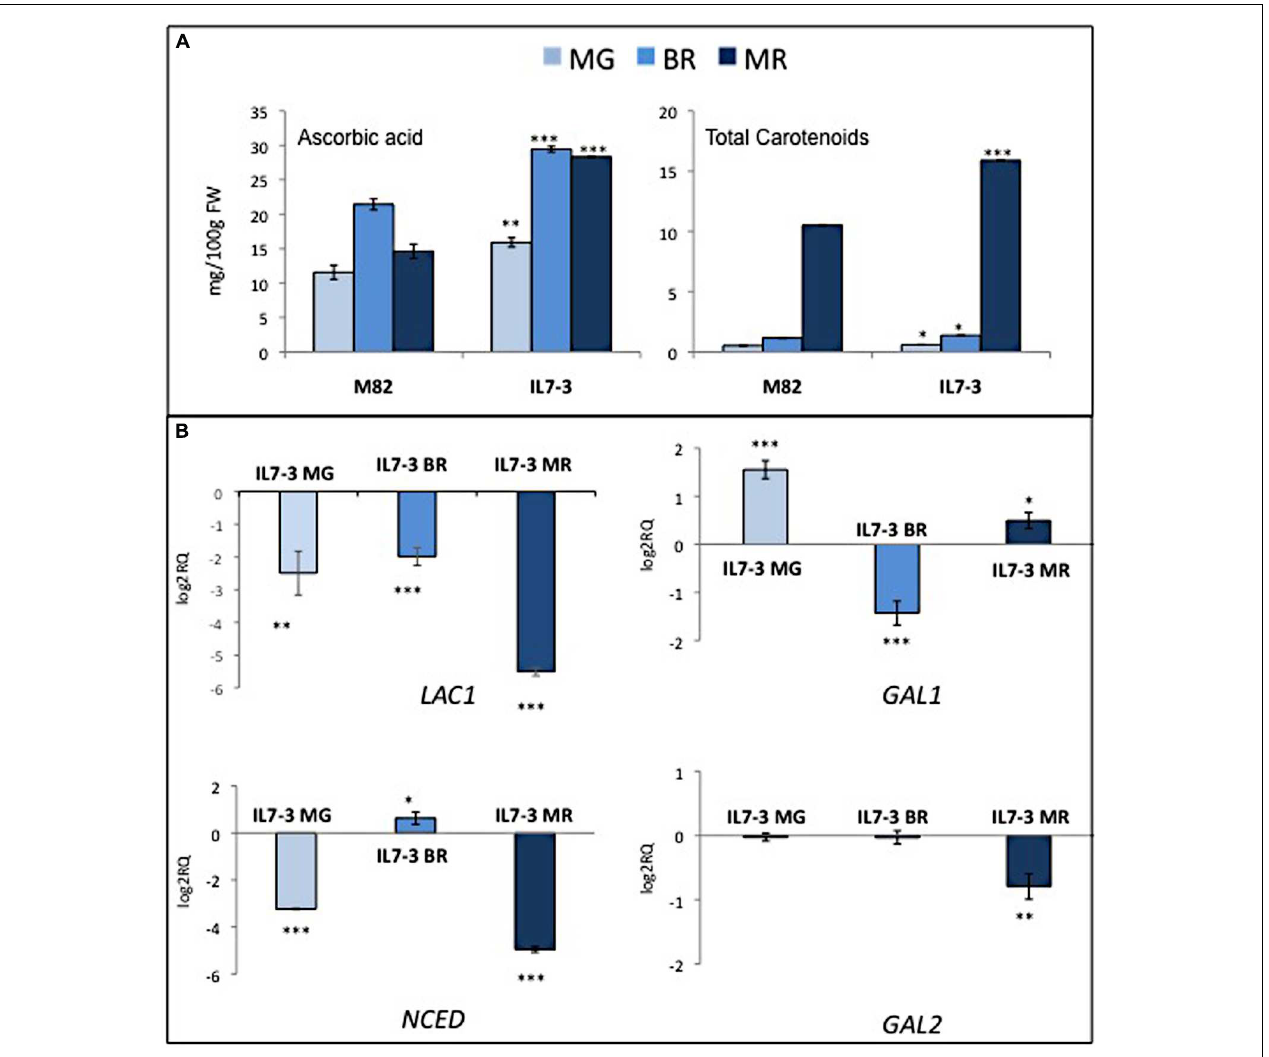
FIGURE 1 | Phenotypic and molecular evaluation of the parental genotypes M82 and IL7-3. (A) Metabolite content (AsA and total carotenoids) at three different ripening stages (MG, mature green; BR, breaker; MR, mature red); (B) Expression level of four selected CGs ( LAC1 : laccase-22/L-ascorbate-oxidase homolog ; GAL1 and GAL2 : β -1-3-galactosiltrasferase ; NCED : 9-cis-epoxycarotenoid dioxygenase ) in IL7-3 at different ripening stages. Asterisks indicate statistically significant differences of each ripening stage to the corresponding M82 stage ( ∗ P < 0.05, ∗∗ P < 0.01, ∗∗∗ P < 0.001).